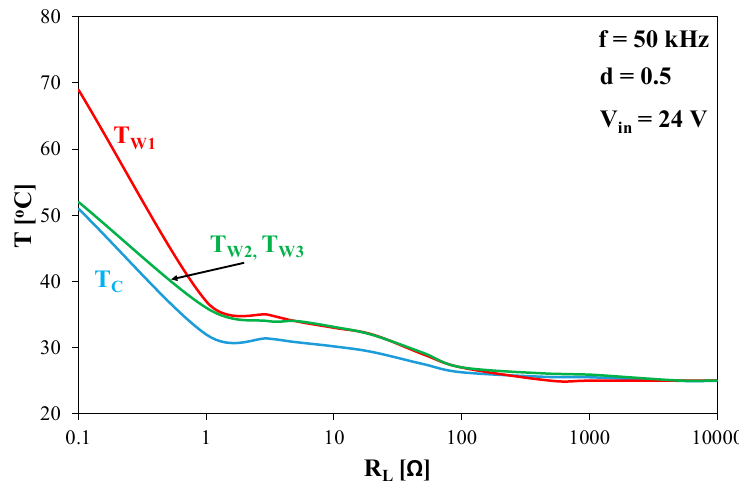
Figure 19. Dependence of the core and winding temperature on the load resistance of the boost converter when the current flows through one coil.